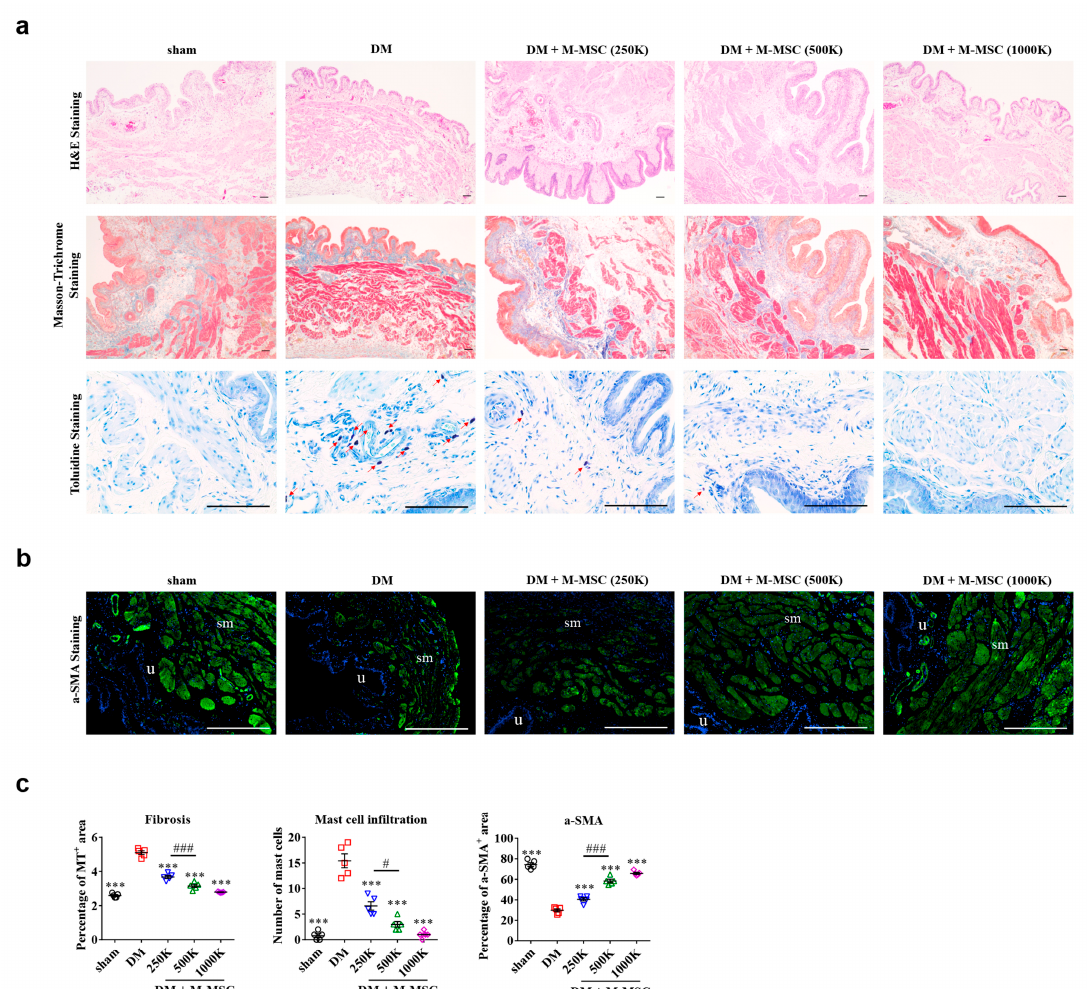
Figure 4. Injection of M-MSCs restored histological abnormalities in DM rat bladders. ( a ) Histological analysis for (i) hematoxylin and eosin (H&E) staining (100× magnification; scale bar, 200 µm), (ii) Masson’s trichrome staining (100× magnification; scale bar, 200 µm), and (iii) toluidine blue staining (400× magnification; scale bar, 100 µm) of bladder tissues from DM rats 1 week after injection of the indicated number of M-MSCs or PBS. ( b ) Immunohistochemical analysis of α -SMA staining (400× magnification; scale bar, 100 µm) of bladder tissues from the indicated groups. Arrows indicate infiltrated mast cells. Sham: non-diabetic sham-operated. ( c ) Quantification of histological staining. Three representative areas per slide were randomly selected from five individual animals per group. Data were normalized against sham-operated rats and are presented as mean ± SEM ( n = 5, *** p < 0.001,